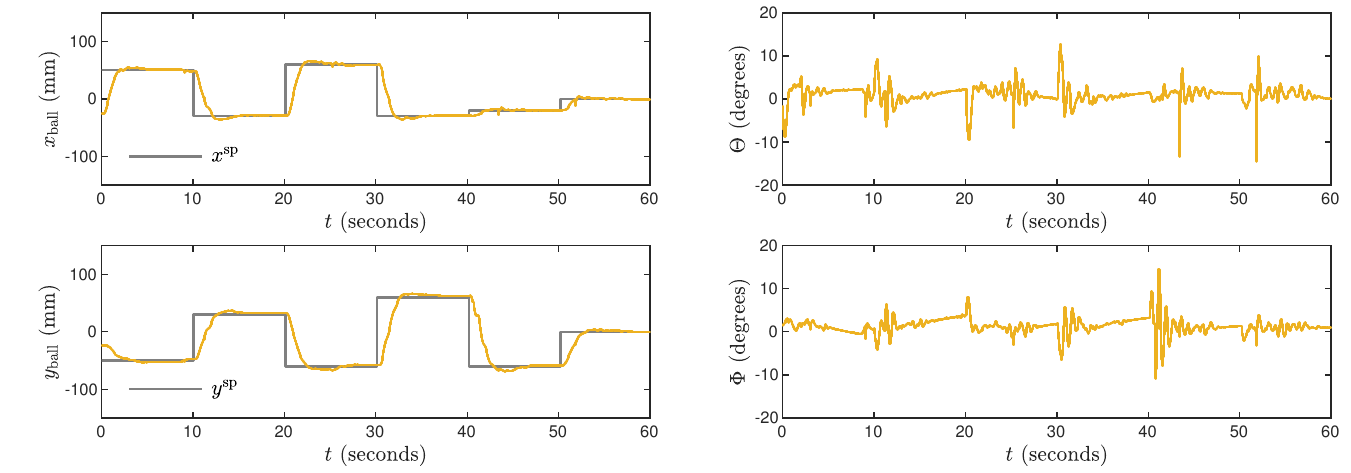
Figure 5. Experimental results of the MPC3 algorithm.